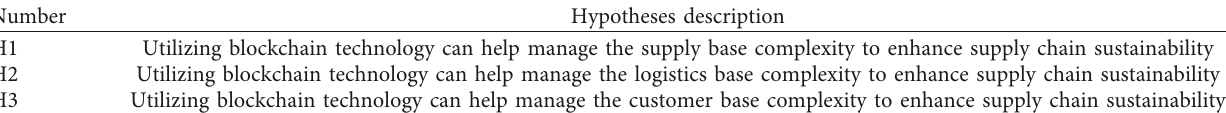
Table 1: The relationship between blockchain technology and supply chain